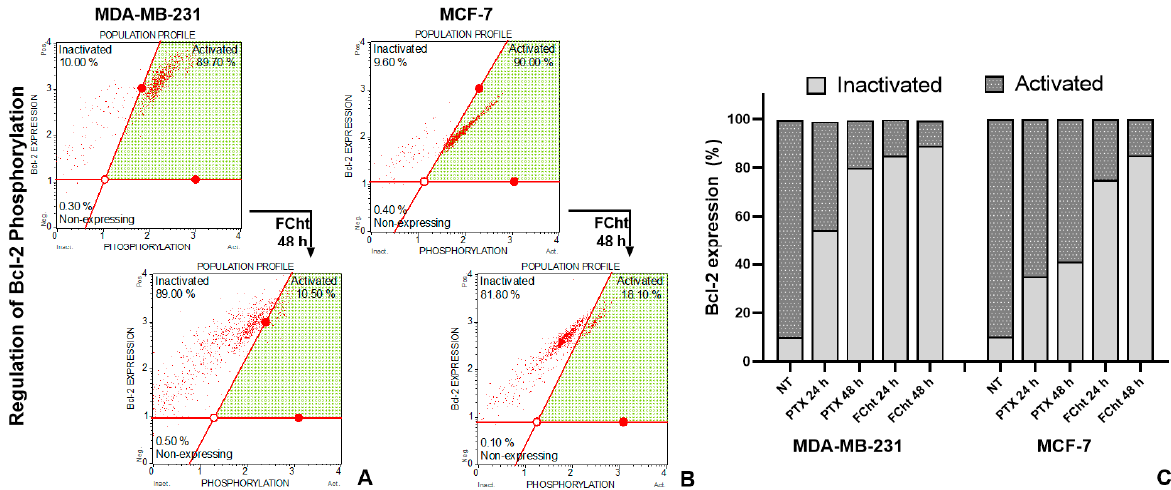
Figure 7. Phosphorylated Bcl-2 at Ser70 detection by flow cytometry on BC cells. The dots (in red) represent a single cell analyzed, and the green area correspond to region of active cells. ( A ) Dot plots comparing untreated MDA-MB-231 cells and cells exposed to Tacotanina at IC 50 for 48 h. ( B ) Dot plots comparing untreated MCF-7 cells and cells exposed to Tacotanina at IC 50 for 48 h. ( C ) Percentage of active and inactive Bcl-2 protein expression in BC cells treated with Tacotanina and the positive control PTX for 24, and 48 h.